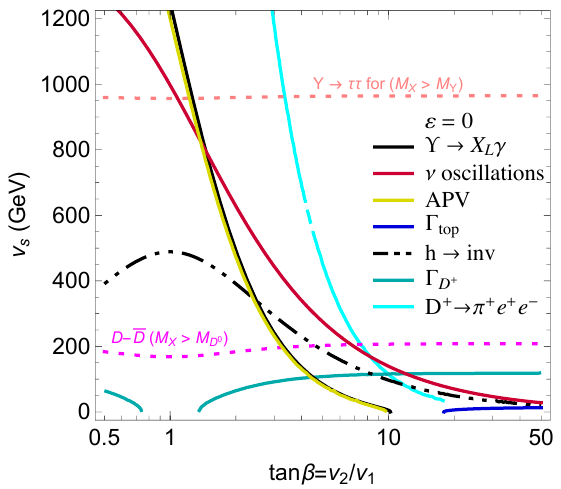
Figure 5. Constraints on the VEV of the SM singlet scalar s as a function of tan (cid:12) (cid:17) v 2 =v 1 from (cid:7) ! X L (cid:13) decay, atomic parity violation (APV), D + ! (cid:25) + (cid:22) + (cid:22) (cid:0) , total D + width, neutrino oscillations, top quark total width, and Higgs invisible decays (see section 4). We also show the bounds on v s from (cid:7) ! (cid:28) + (cid:28) (cid:0) and D 0 (cid:0) D 0 mixing, although they only apply for M X (cid:29) M (cid:7) and M X (cid:29) M D 0 , respectively (see (cid:12)gure 2 and